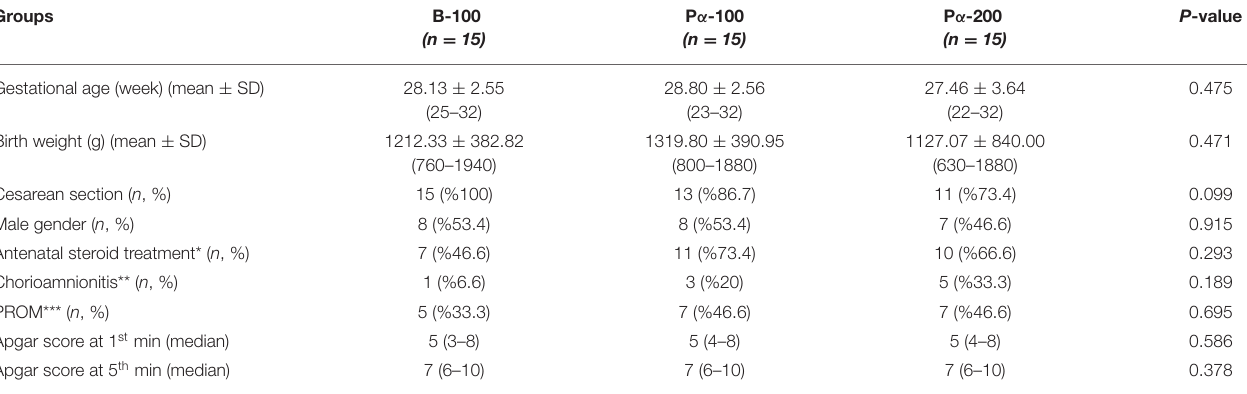
TABLE 1 | Comparison of demographic characteristics of the groups. Groups